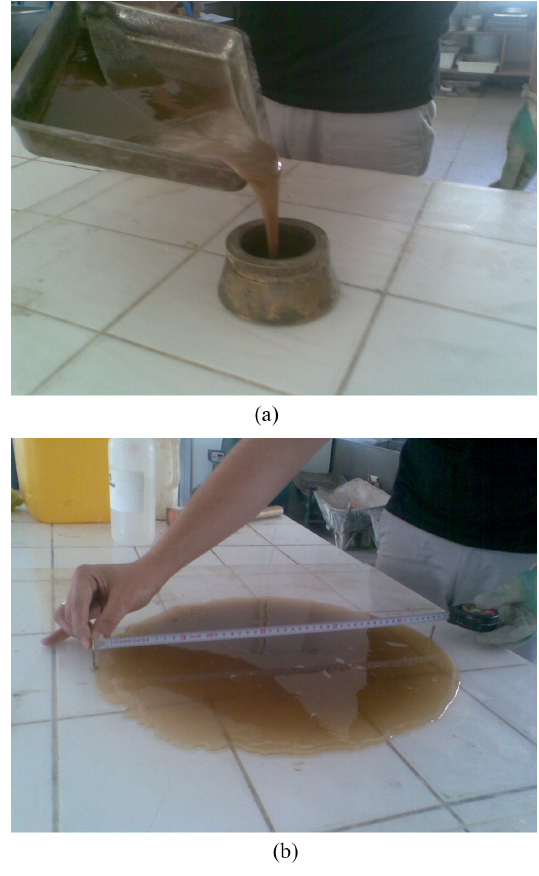
Figure 2. Slump-flow measurement with frustum (a: mini-slump frustum; b: measurement of mortar